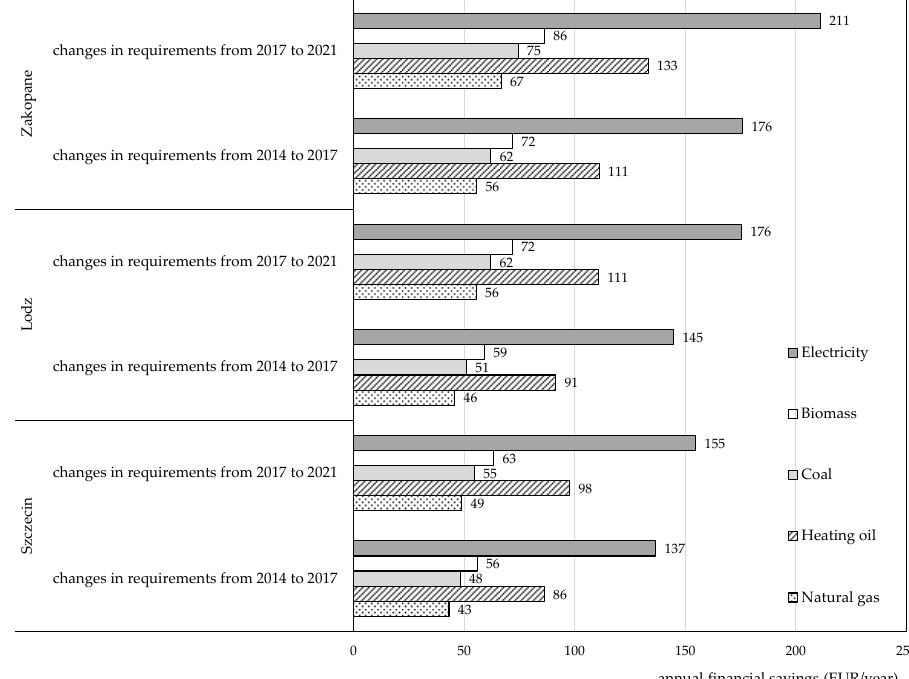
Figure 3. Annual financial savings caused by a change in the requirements for thermal protection of the building envelope (own elaboration). Table 9. Reduction of CO 2 emissions in the analyzed